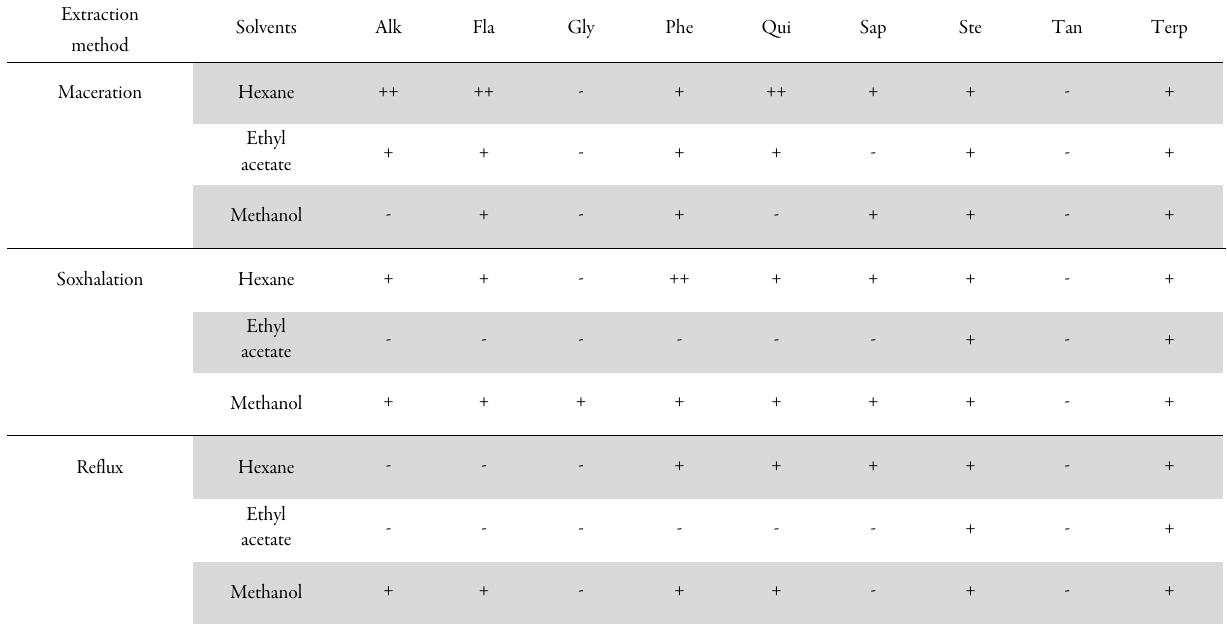
Table 1. Preliminary phytochemical screening of fruit extracts of M. cymbalaria with different solvents (methanol, ethyl acetate and hexane) obtained by maceration, soxhalation and reflux methods Extraction